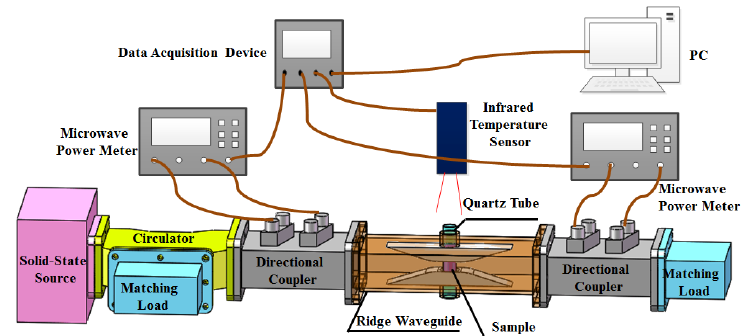
Figure 2. Schematic of the experiment setup.